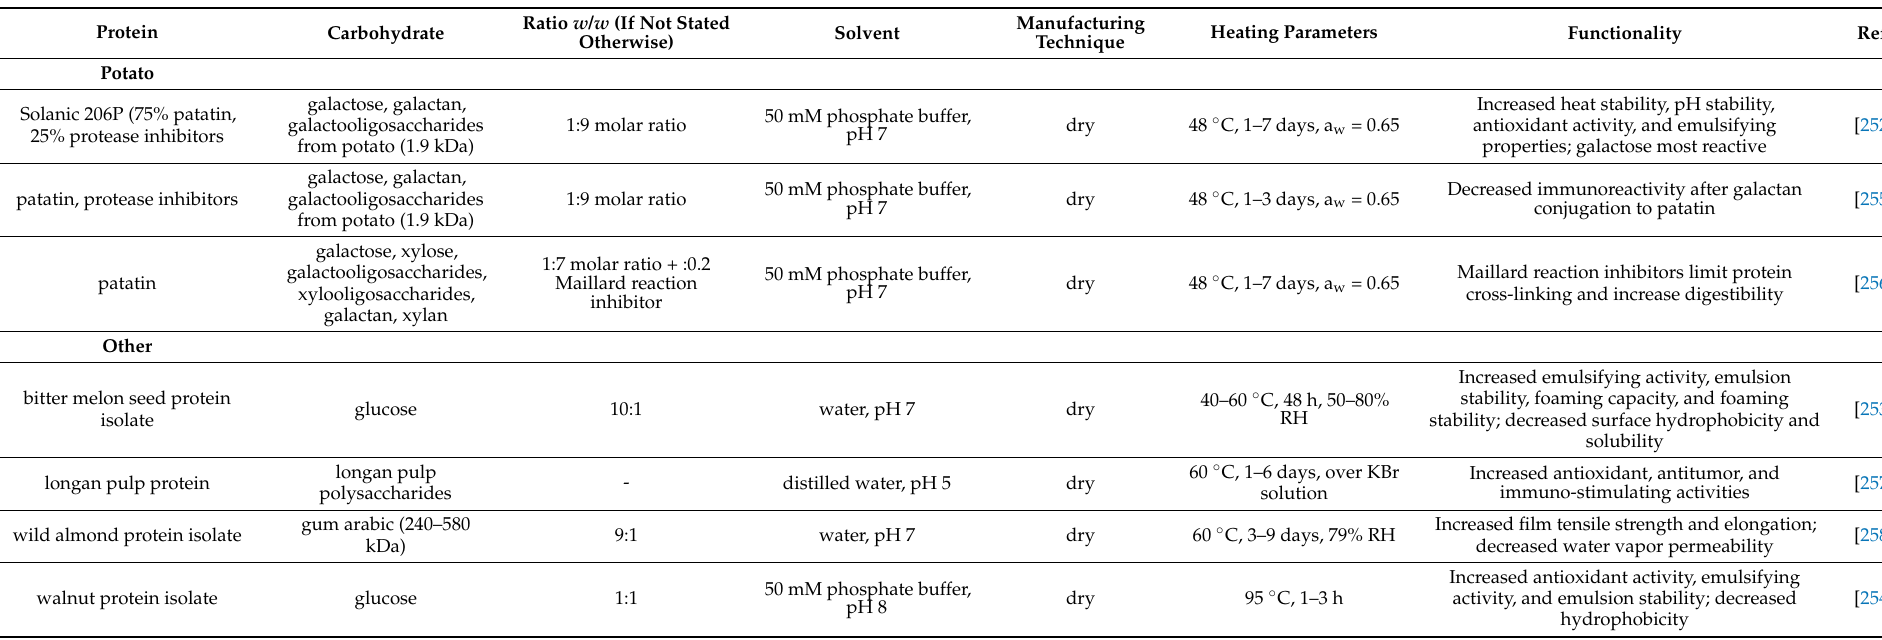
Table 4. Overview of proteins from various sources glycated with various carbohydrates under different reaction conditions and their functionalities. Protein Carbohydrate Solvent Manufacturing Technique Heating Parameters Functionality